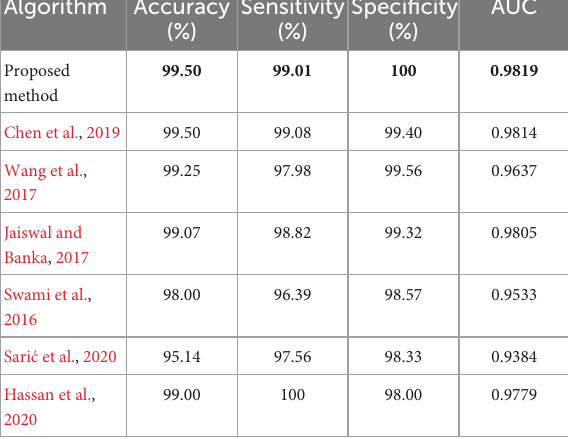
TABLE 4 Comparison of the efficiency of the proposed method with previous methods.